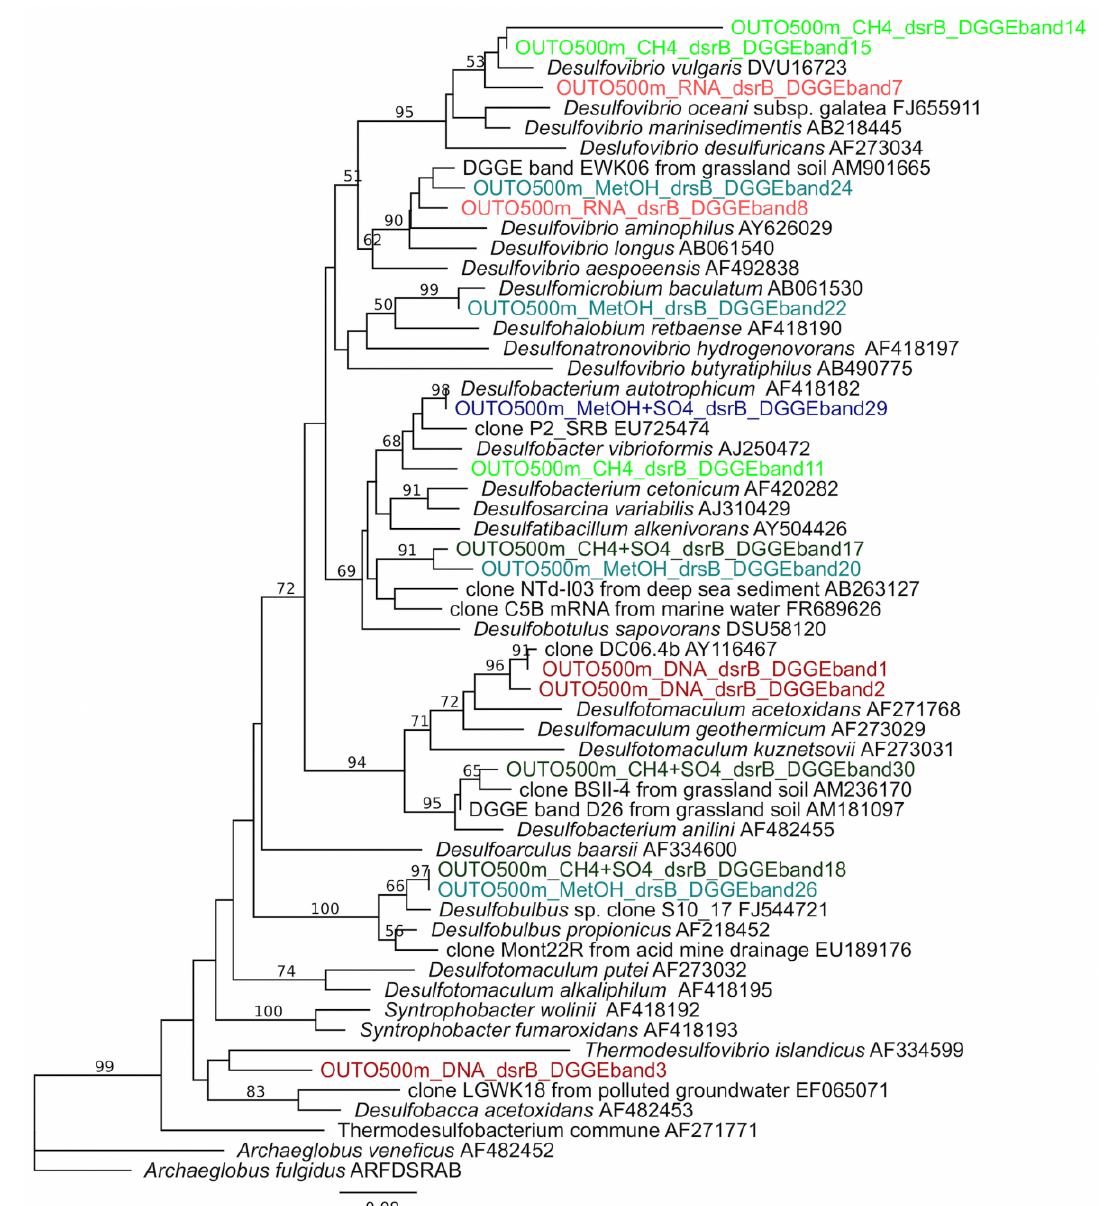
Figure 3. Phylogenetic tree of SRB based on dsr B amino acid sequences obtained by PCR-DGGE and in relation to cultured SRB and the closest uncultured relatives. The dsr B sequences from DNA and RNA (directly obtained from untreated fracture fluid) and substrate induced samples are represented in different colours, DNA—red, RNA—light red, CH 3 OH—light blue, CH 3 OH + SO 42− —blue, CH 4 —light green and CH 4 + SO 42− —green. The band number indicates the DGGE band number in Fig. S1. Nonparametric bootstrap values are shown at nodes found in >50% of 1000 pseudoreplicates. The scale bar indicates 0.08 amino acid substitutions. The tree is rooted by Archaeglobus